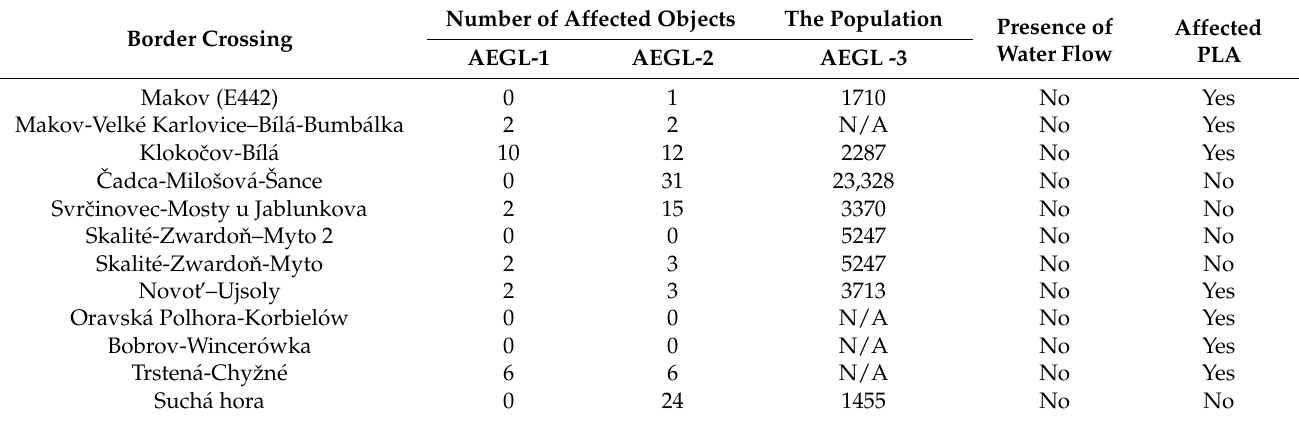
Table 1. Evaluation of the impacts of the leakage of a dangerous substance on the population and environment at individual border crossings [26–28,30]. The Population Presence